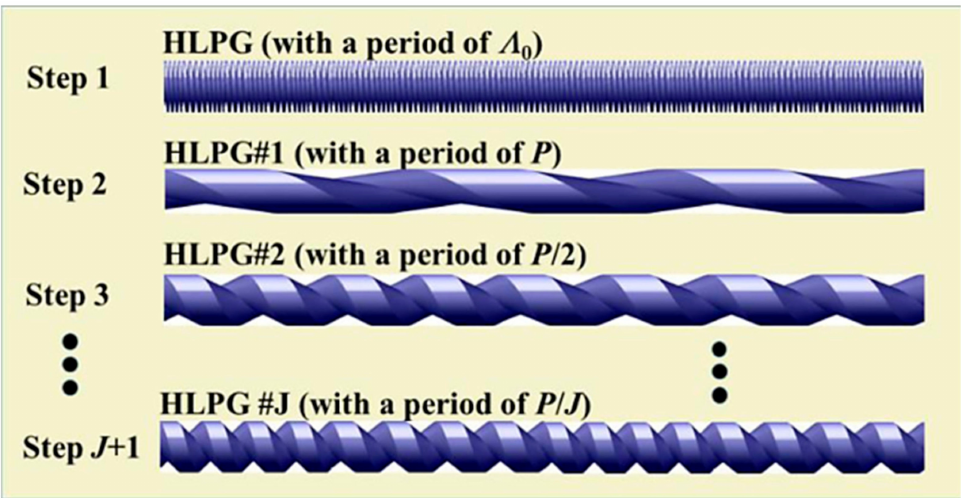
Figure 36. Schematic diagram of the superimposed HLPG. Adapted with permission from ref. [178]. © [2022]